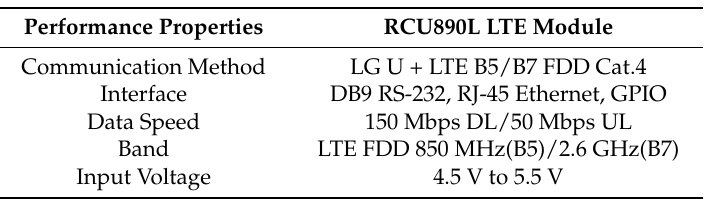
Table 5. Specifications of the LTE